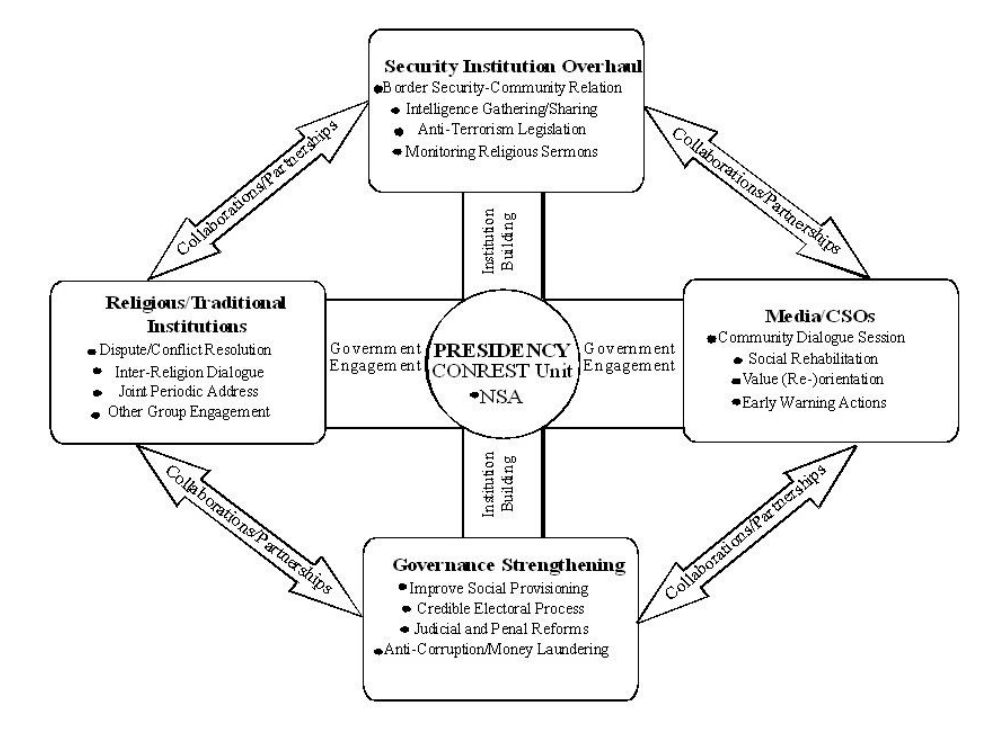
Figure 1: Counter Religious Extremism and Terrorism (CONREST) Strategy for Nigeria (Source: Author